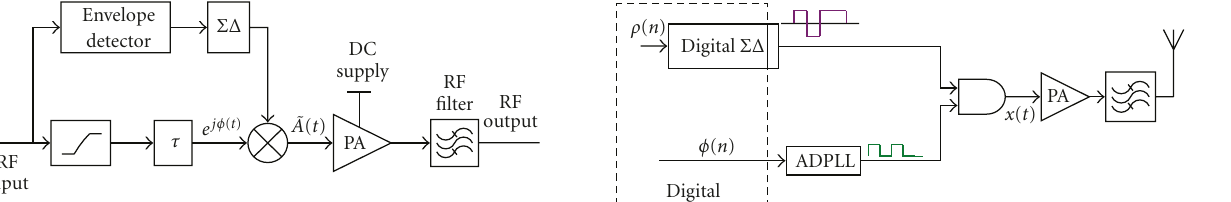
Figure 4: Architecture of the polar ΣΔ transmitter with digital